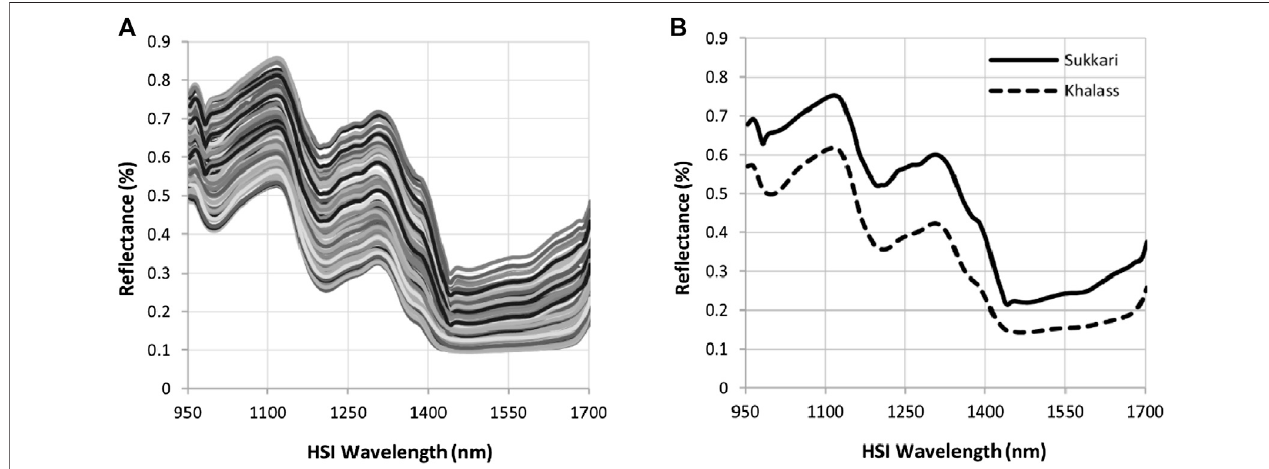
FIGURE 4 | Hyperspectral behavior of date varieties. (A) Original hyperspectral wavelength and (B) mean of the hyperspectral wavelength of Khalas and Sukkari dates cultivars.